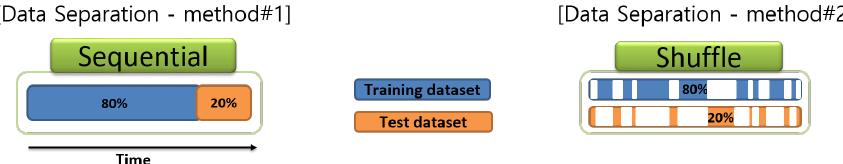
Figure 5. Default data separation methods for the training dataset and test dataset. 20% of the training dataset is used for the validation dataset to prevent the over-fitting calibration model.